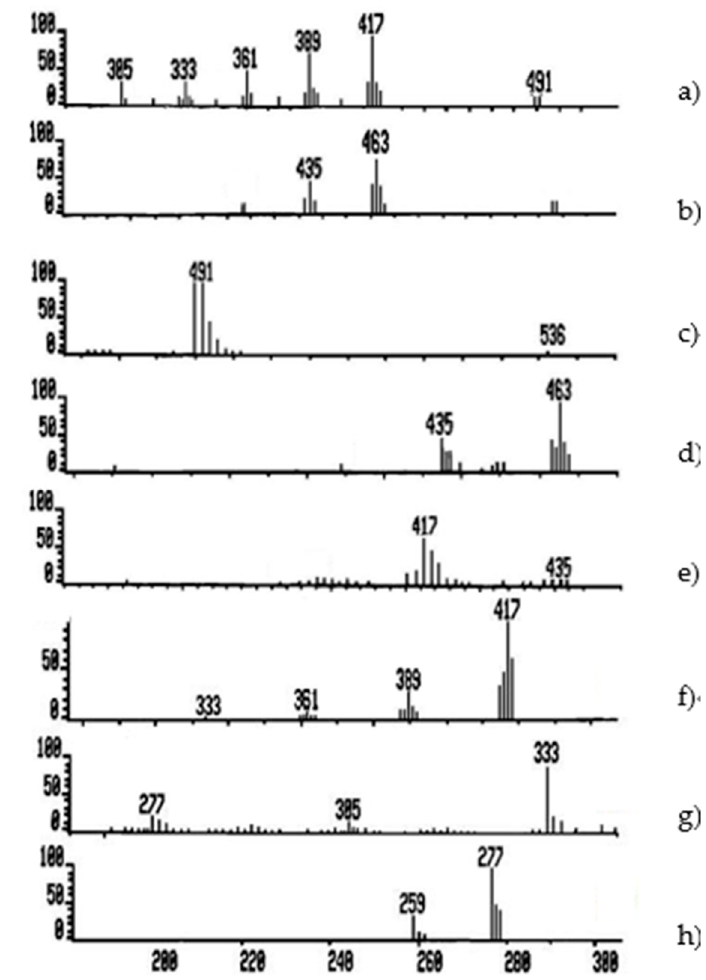
Figure 3. The linked scan B/E(1-E)1/2 for the elimination of ethylene ( a ) and ethanol ( b ) and the linked scan B/E for the daughter ions ( c – h ).